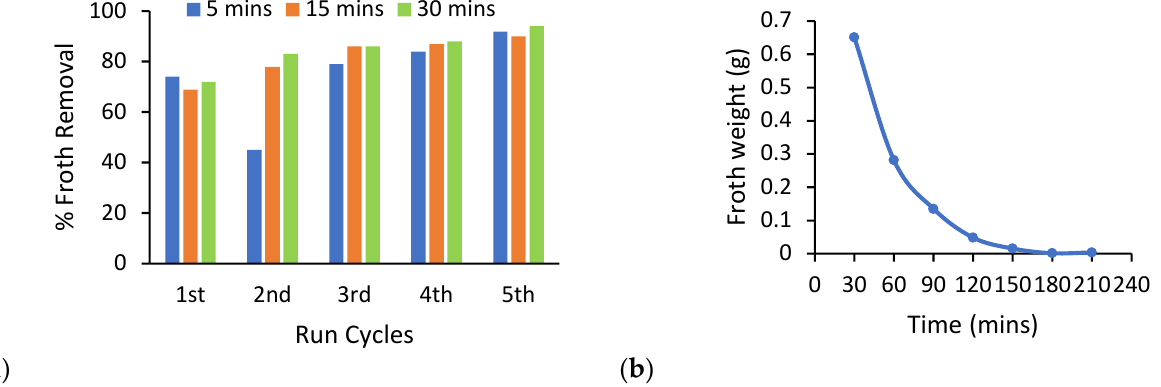
Figure 3. Bitumen recovery ( a ) percentage of froth removal after 5, 15, and 30 min interval cycles of WAO and ( b ) extraction of froth by weight during WAO.